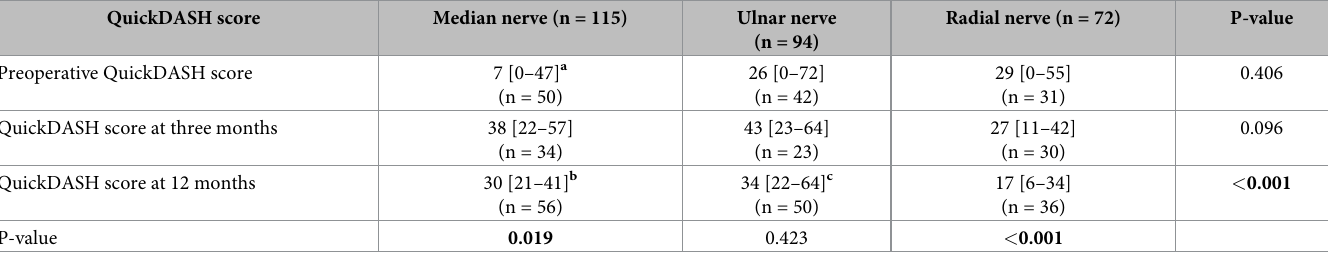
Table 3. QuickDASH score for individuals treated with repair or reconstruction of an injured major nerve trunk injury in the upper extremity. QuickDASH